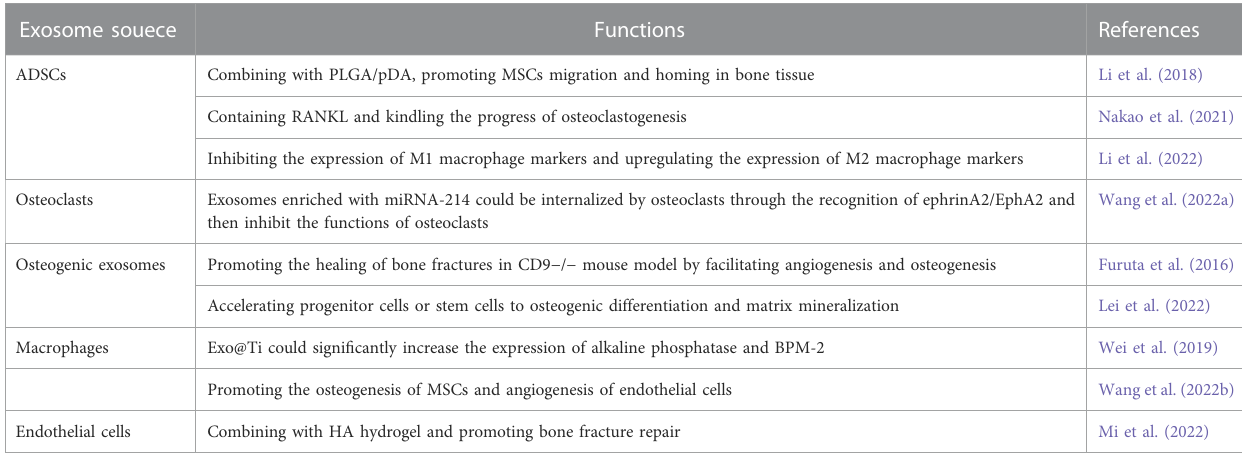
TABLE 1 Application of exosomes for bone tissue